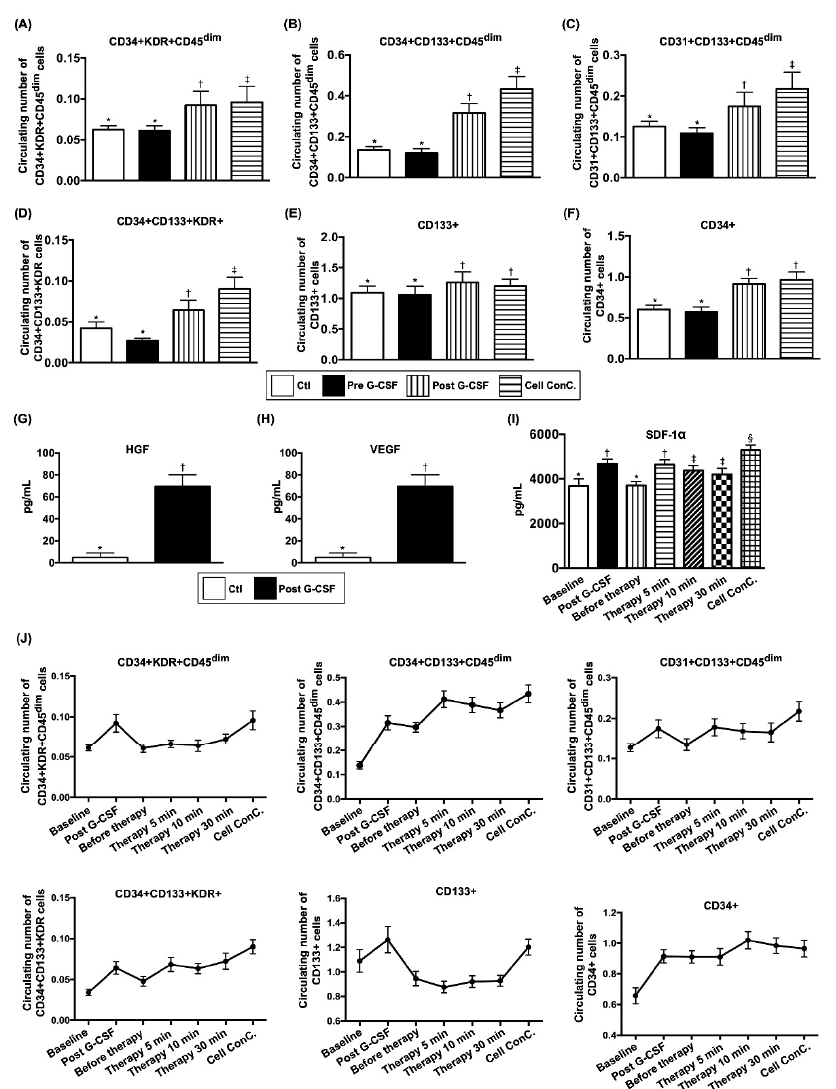
Figure 2. Circulating EPC surface markers and soluble angiogenesis factors between group 1 and group 2 patients prior to and in group 1 after G-CSF treatment, and the time courses of EPC populations and SDF-1 α concentration in coronary sinus (CS) among group 1 patients. ( A ) Circulating number of CD34 + KDR + CD45 dim cells, * vs. other groups with di ff erent symbols ( † , ‡ ), p < 0.0001. ( B ) Circulating number of CD34 + CD133 + CD45 dim cells, * vs. other groups with di ff erent symbols ( † , ‡ ), p < 0.0001. ( C ) Circulating number of CD31 + CD133 + CD45 dim cells, * vs. other groups with di ff erent symbols ( † , ‡ ), p < 0.0001. ( D ) Circulating number of CD34 + CD133 + KDR + cells, * vs. other groups with di ff erent symbols ( † , ‡ ), p < 0.0001. ( E ) Circulating number of CD133 + cells, * vs. † , p < 0.001. ( F ) Circulating number of CD34 + cells, * vs. † , p < 0.0001. Clt = control group (i.e., group 1); pre-G-CSF = indicated prior to G-CSF treatment in study group (SG) (i.e., group 1). ( G ) ELISA result of circulating hepatocyte growth factor (HGF), * vs. † , p < 0.0001. ( H ) ELISA result of circulating vascular endothelial growth factor (VEGF), * vs. † , p < 0.0001. SG (study group) (i.e., group 1), pre-G-CSF = indicated prior to G-CSF treatment in SG; post = indicated post G-CSF treatment in SG. ( I ) The baseline and the time courses of stromal cell-derived factor (SDF)-1 α in CS, * vs. other groups with di ff erent symbols ( † , ‡ , §), p < 0.001. ( J ) The baseline and the time courses of EPCs populations in coronary sinus, p for trend < 0.001 for each EPC surface marker. All statistical analyses were performed by one-way ANOVA, followed by Bonferroni multiple comparison post hoc test ( n = 30 for each group). Symbols (*, † , ‡ ) indicate significance (at 0.05 level). G-CSF = granulocyte-colony stimulating